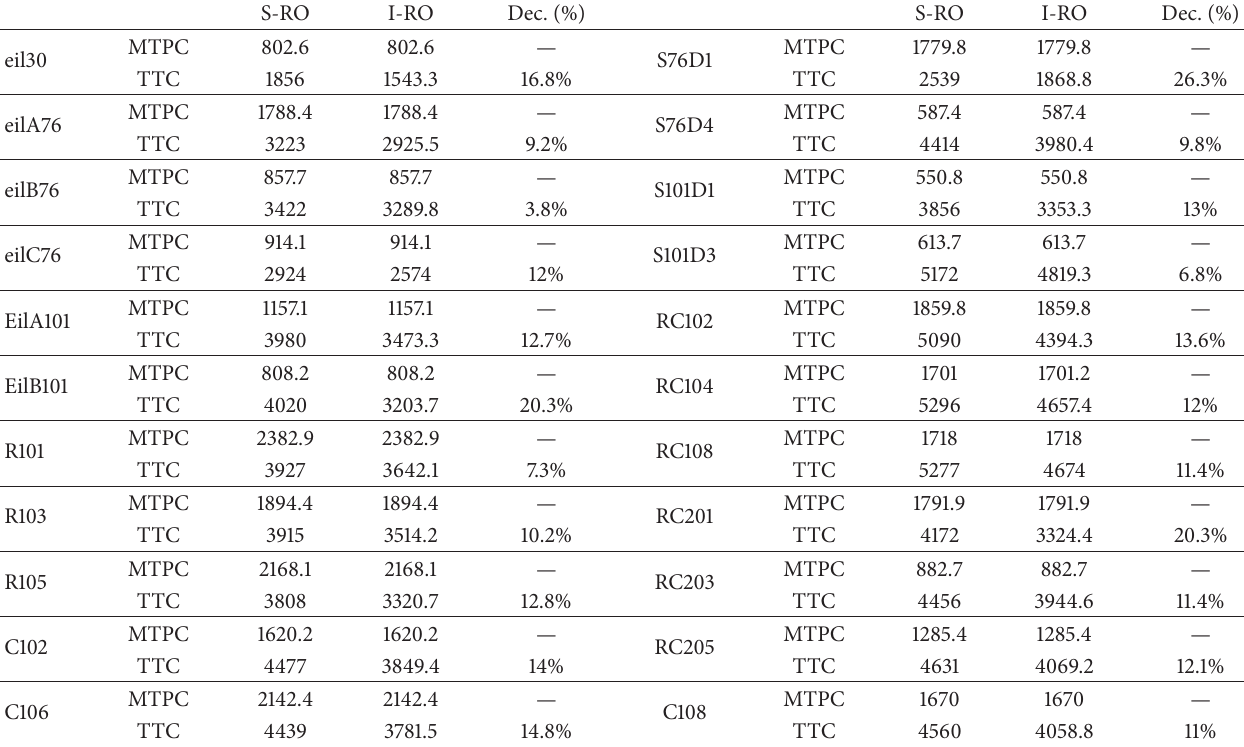
Table 1: Computational results: I-RO and S-RO.